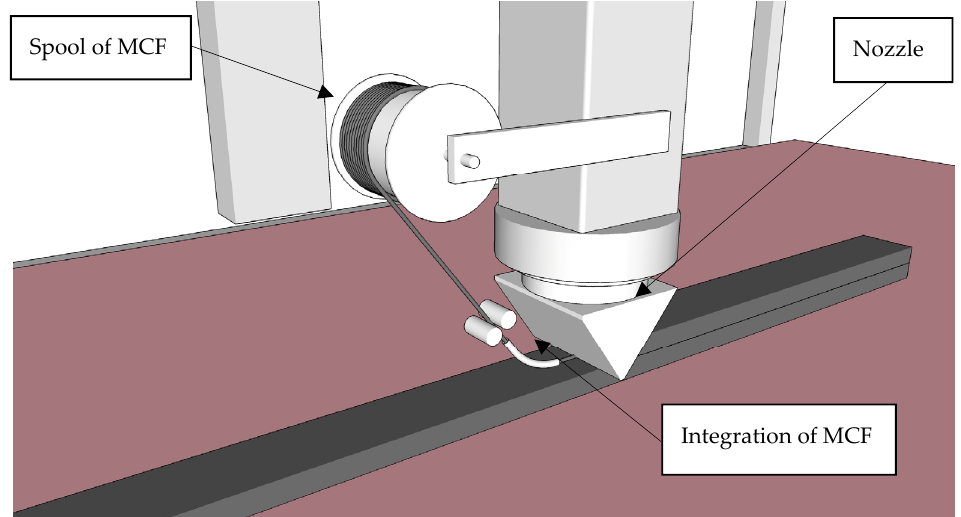
Figure 2. 3D concrete printing with Mineral-impregnated Carbon-Fibre (MCF) supply from a spool.